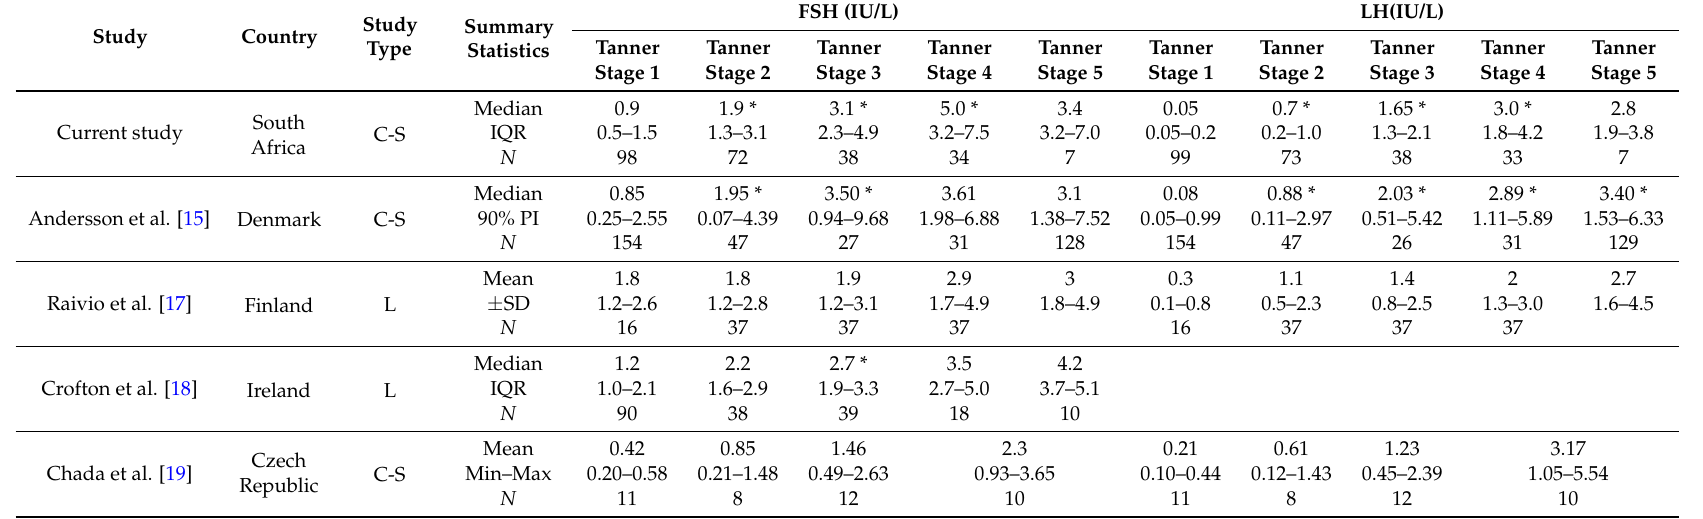
Table 6. Levels of gonadotropins during sexual development in this study compared with other published